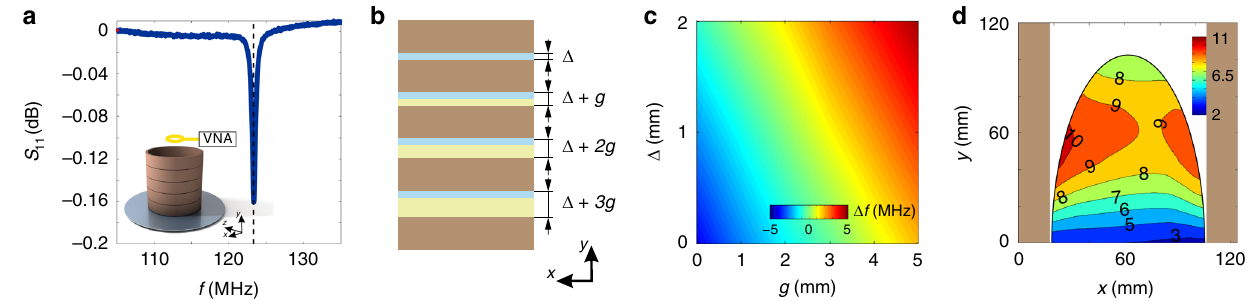
Fig. 2 Resonator tuning principle and results of electromagnetic simulations. a An illustration of the dielectric resonator prototype for targeted breast MRI at 3 Tesla. Correspondence of the device resonance frequency to the operational frequency of the used 3 Tesla clinical MR system (a vertical dashed black line) is shown with the S 11 measurements (blue curve). b , c The gaps between the discs of the resonator are used to tune the resonator to the operating frequency of a particular MR system. That makes the resonator universal. d An RF safety gain map inside the breast in the case of the body birdcage coil used in combination with the ceramic resonator relative to the birdcage coil alone. Different values and colors correspond to different RF safety gain values in different parts of the breast associated with inhomogeneities of root-mean-square value of the transmit RF electromagnetic fi eld. Brown shaded areas show the boundaries of the resonator.